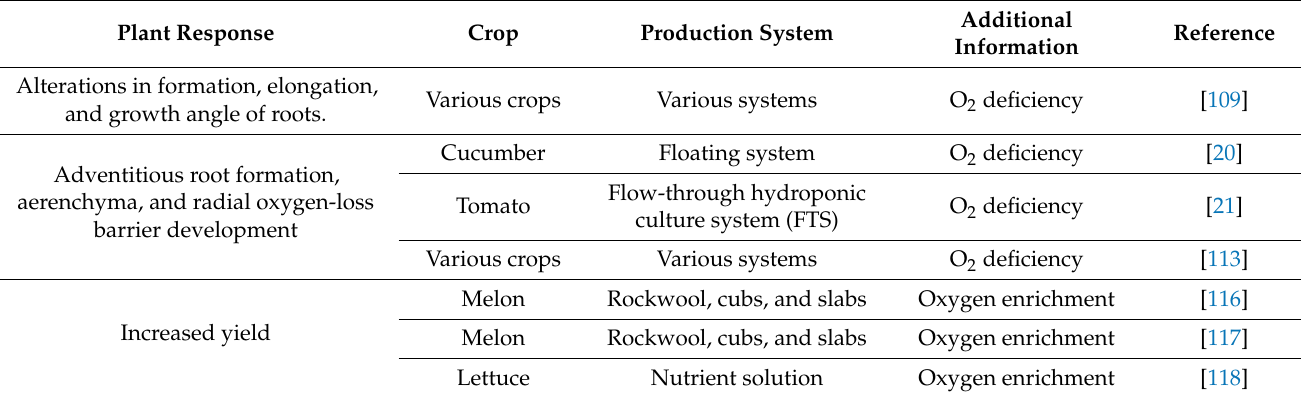
Table 5. Plant responses to rootzone